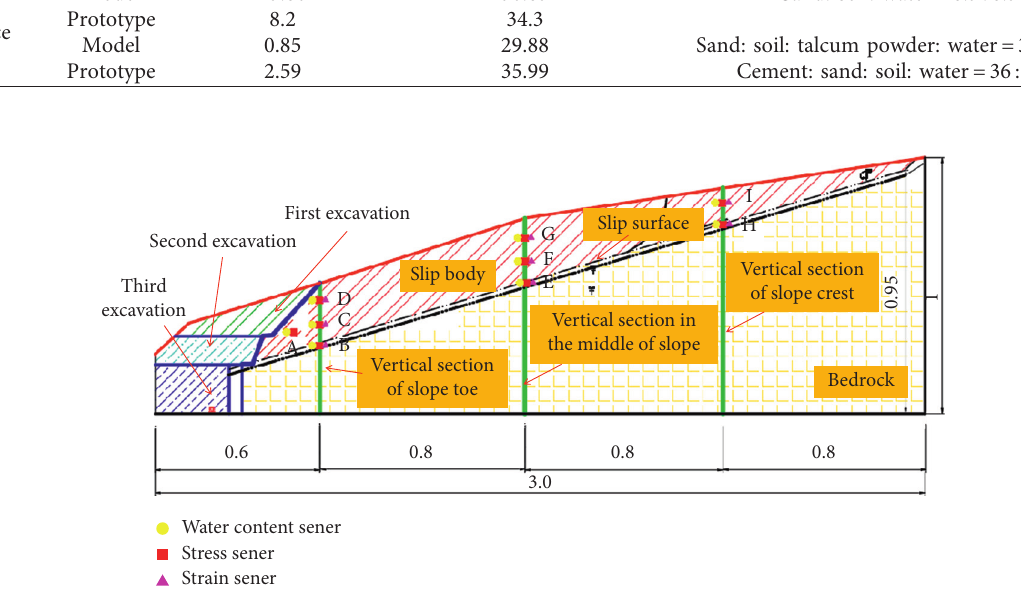
Figure 8: Schematic diagram of sensor layout (unit: